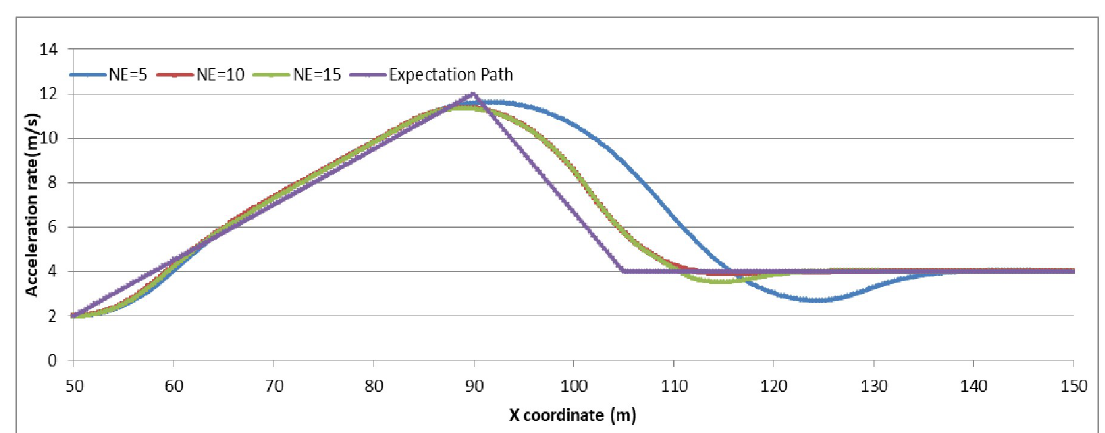
Fig 9. The B-Class vehicle driving trajectory for different N E (Group